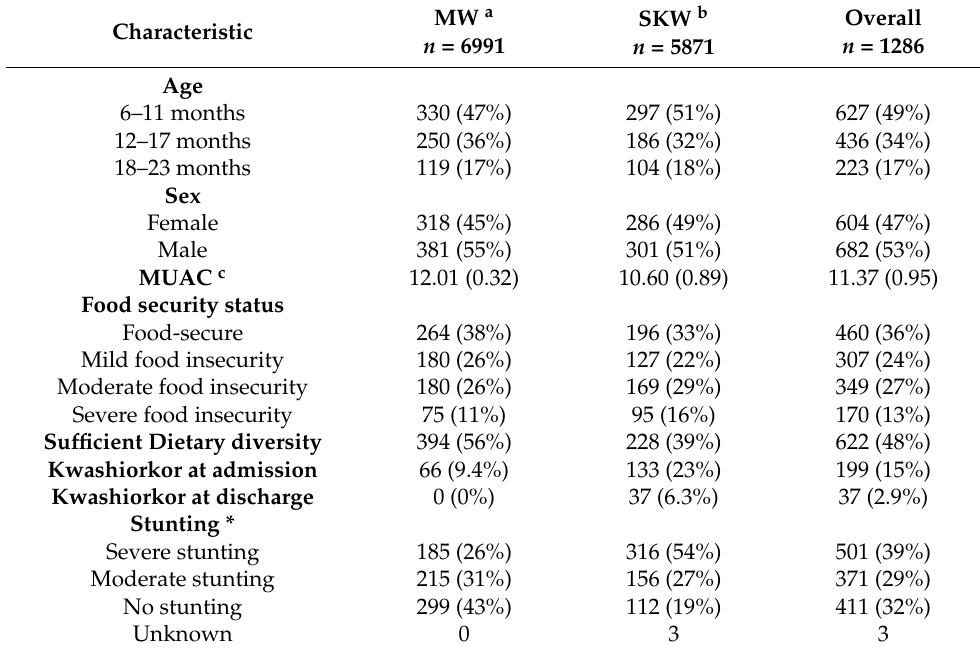
Figure 1. Flow chart for study participant inclusion. Table 1. Baseline children, caregiver, and household characteristics, and relationship with nutritional status at the time of hospital